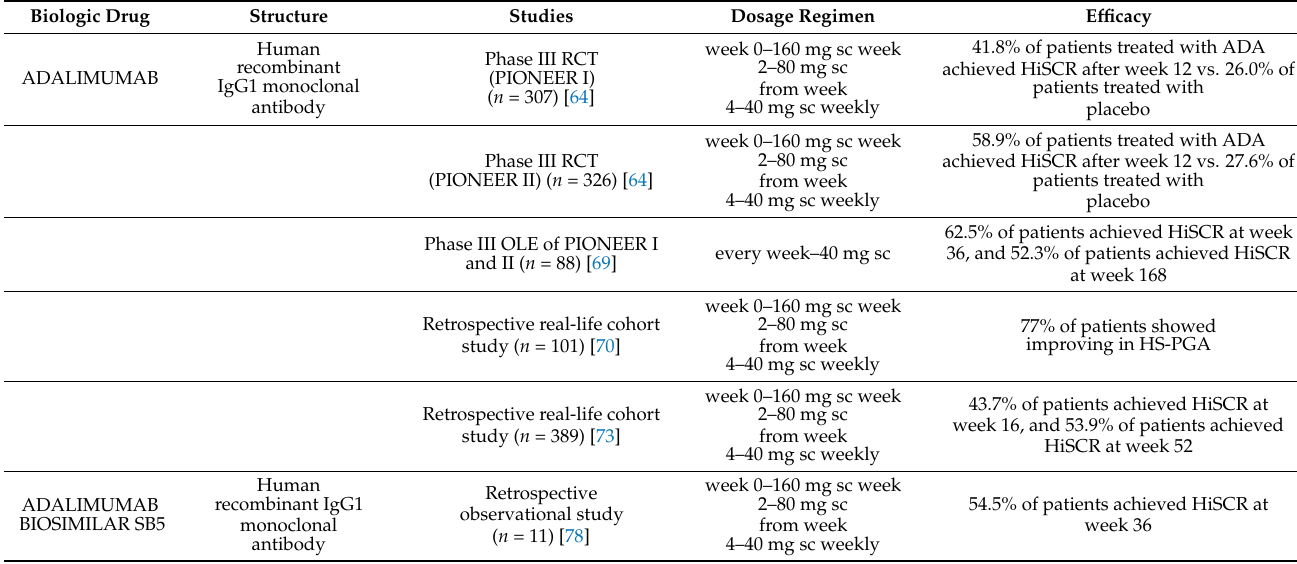
Table 3. Anti-TNF- α agents for HS